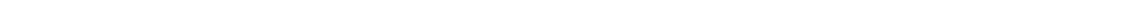
Fig. 7 Chronotherapeutic effects of D -allulose (3 g kg − 1 day − 1 ) on hyperphagic obesity in HFD-fed mice. a – k HFD-fed obese C57BL/6J mice (HFD-fed) were subchronically treated for 10 days with p.o. Allu (3 g kg − 1 day − 1 ) or water once daily at LP 7:30. C57BL/6J lean mice fed standard chow (Chow-fed) were the lean control. Allu, compared to water, markedly attenuated increases in LP and daily HFD intake ( a – c ) and body weight gain ( d ). Subchronic Allu treatment ameliorated increased visceral WAT weight ( e ), hepatic steatosis ( f ), and elevated triacylglycerol content in liver ( g ) on Day 11. Scale bar, 200 µ m. Allu treatment signi fi cantly ameliorated elevated basal blood glucose ( h ) with trend to attenuate hyperinsulinemia on Day 11 ( i ). In ipGTT at Day 11, rises in blood glucose at 60 and 120 min were markedly suppressed ( j ), and basal (0 min) and elevated plasma insulin levels at 15 and 30 min tended to decrease ( k ). l – s In HFD-fed Glp1r KO mice, the same subchronic Allu treatment did not alter LP HFD intake ( l , n ), slightly elevated DP HFD intake at Day 4 and later ( m , n ), and failed to signi fi cantly change body weight gain ( o ), visceral WAT weight on Day 11 ( p ), and blood glucose level ( q ) and its AUC ( r ) in ipGTT on Day 11 except an increase of blood glucose level at 30 min in ipGTT ( q ). Before sacri fi cing these Glp1r KO mice, portal vein was sampled 60 min after p.o. Allu (3 g kg − 1 ) or saline and active GLP-1 was determined ( s ). n = 5 – 6. Different letters p < 0.05 and ** p < 0.01 by two-way ANOVA followed by Tukey ’ s test ( a , d , h ) or Bonferroni ’ s test ( j , q ). # p < 0.01 by two-way ANOVA followed by Bonferroni ’ s test vs. Day 0 ( h ). In m , effect of Allu treatment was signi fi cant with p < 0.05 by two-way ANOVA. * p < 0.05, and ** p < 0.01 by one-way ANOVA followed by Tukey ’ s test ( c , e , g , i ). * p < 0.05, and ** p < 0.01 by unpaired t -test vs. saline group ( n , s ). Error bars are